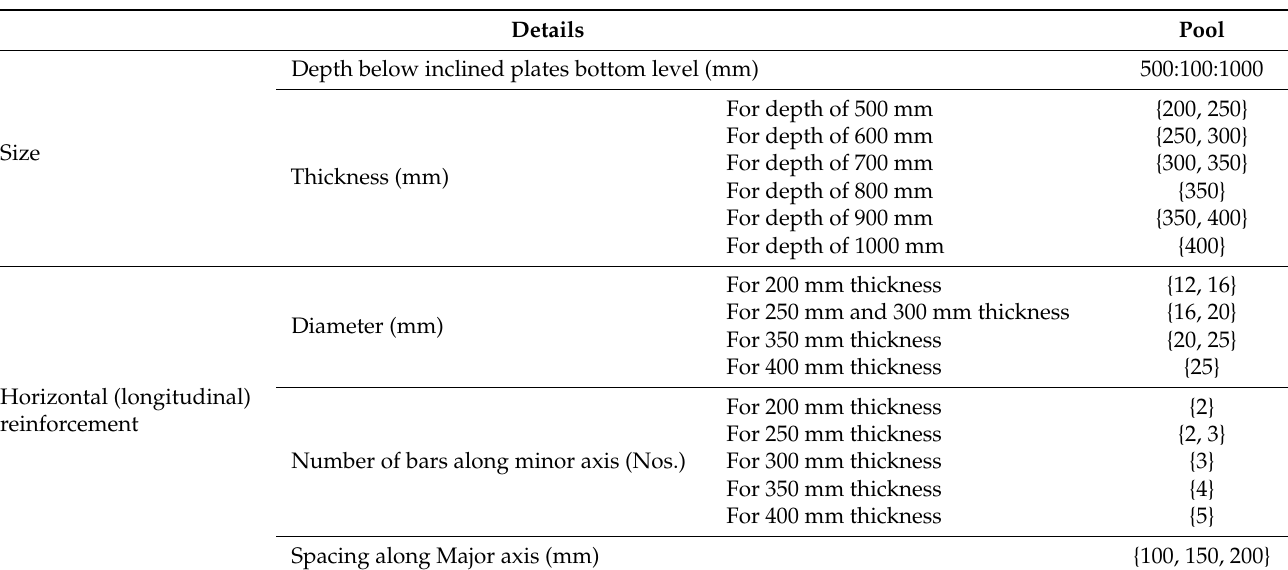
Table 4. Diaphragm variables design